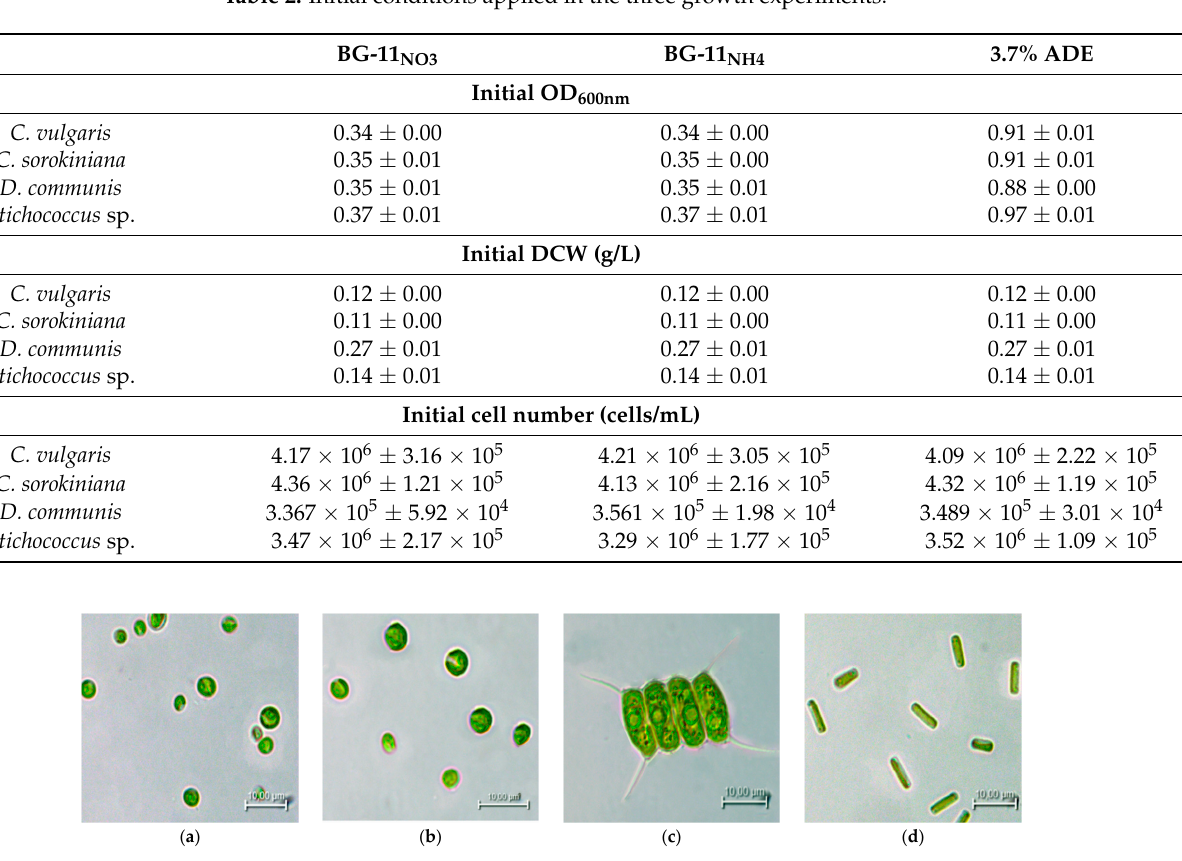
Table 2. Initial conditions applied in the three growth experiments.